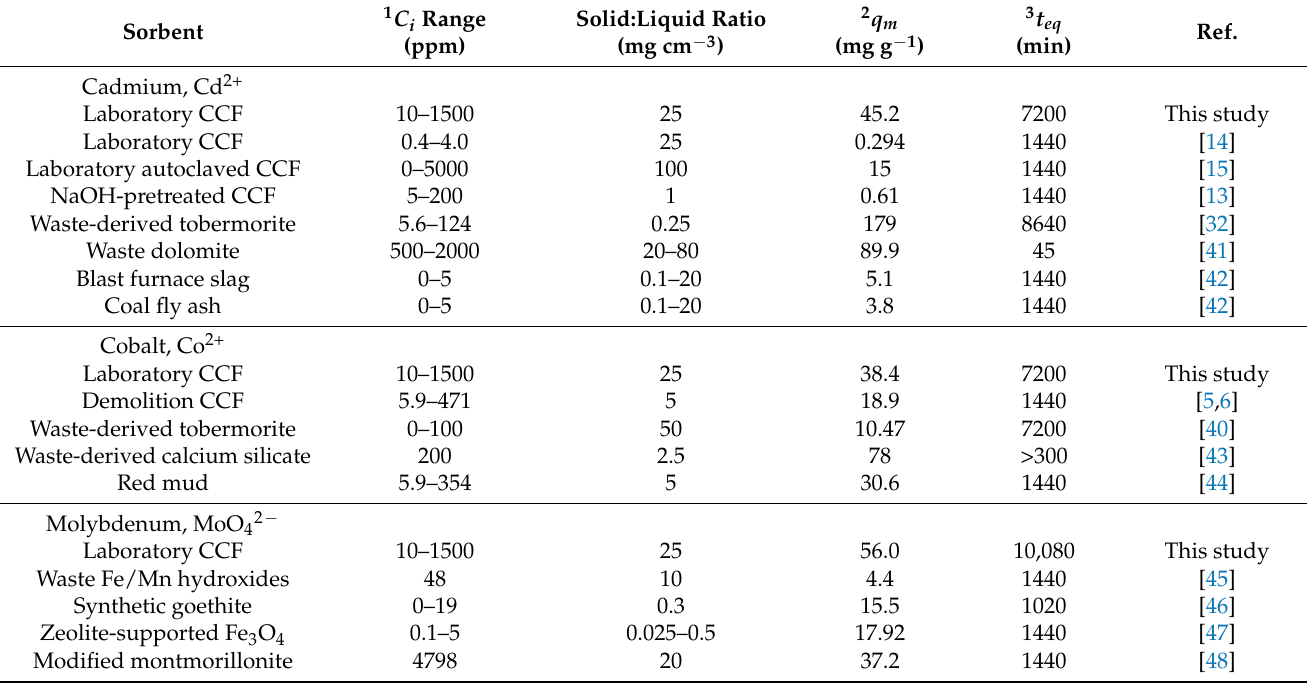
Table 5. Comparison of the removal characteristics of CFF for Cd 2+ , Co 2+ and MoO 42 − with those of other crushed concretes and inorganic